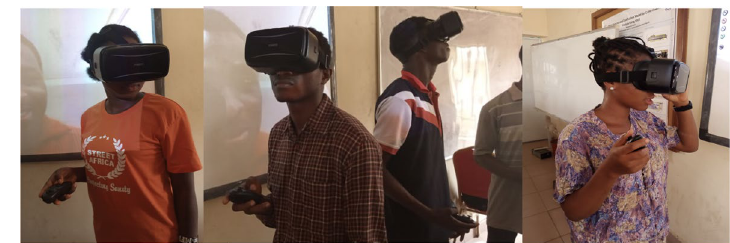
Fig. 4 Images showing how participants were engaged in playing the VR mini